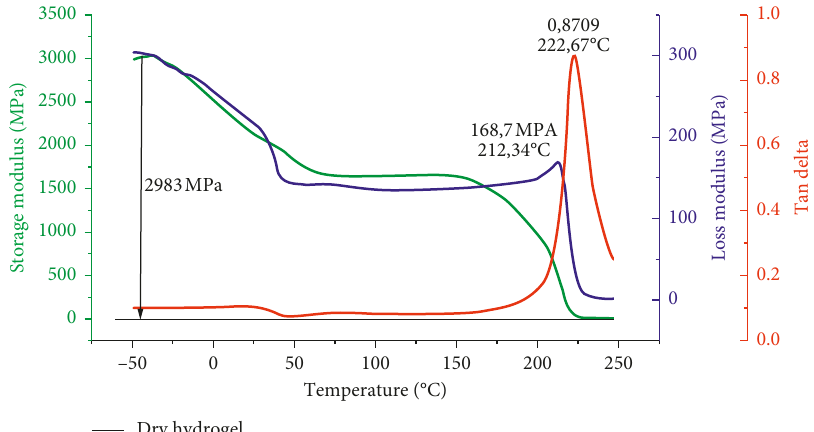
Figure 6: Dynamic-mechanical analysis curves with a temperature ramp between − 50 and 250 ° C for the dry HAC-EDTA film sample.